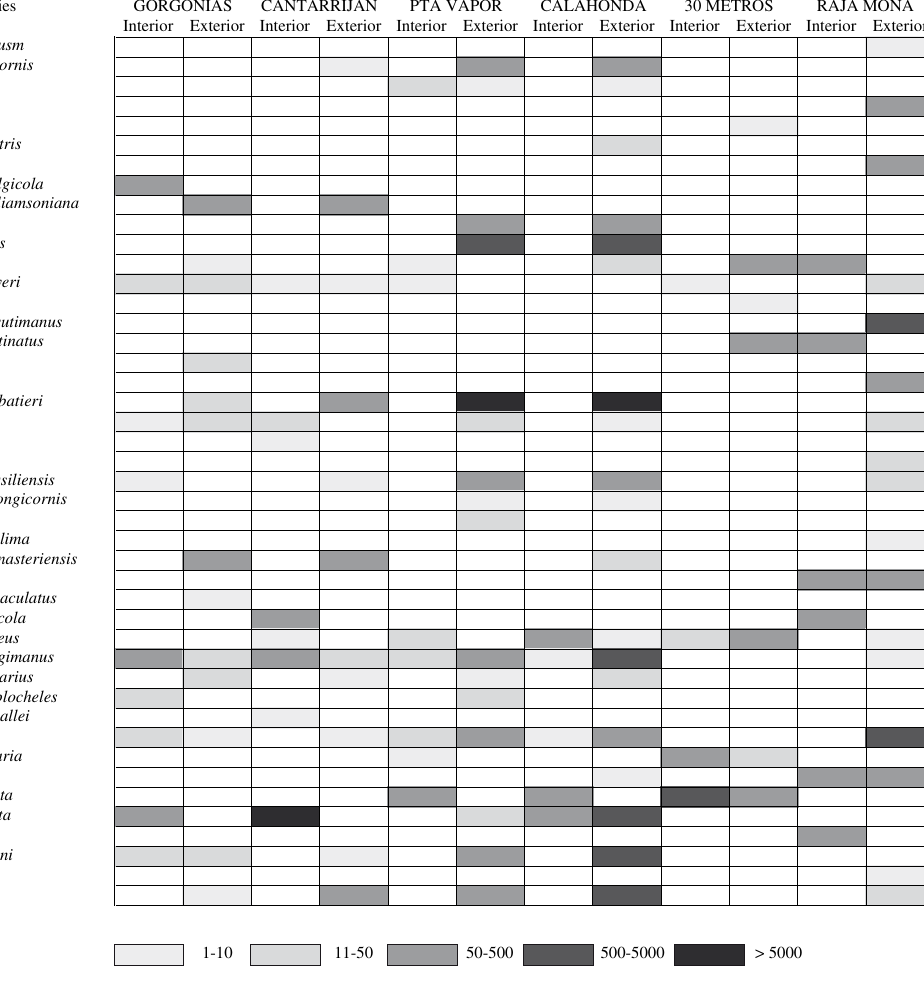
Fig. 1. – Mean abundance (ind/m 2 ) of the amphipod species at each sampling